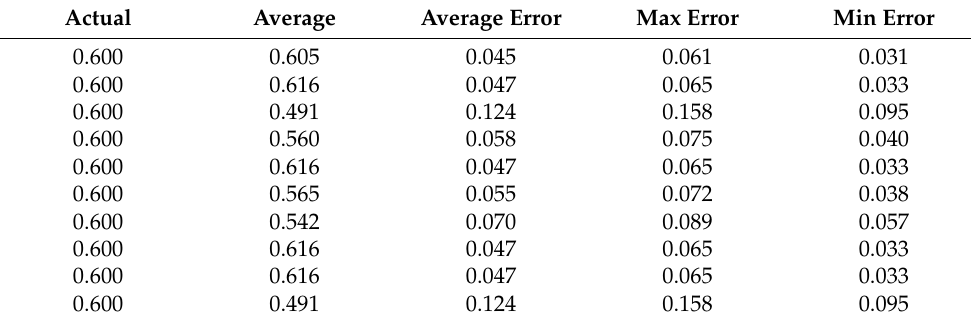
Table A112. Set 2, trials 21–30 data (all 0.5 PR values).